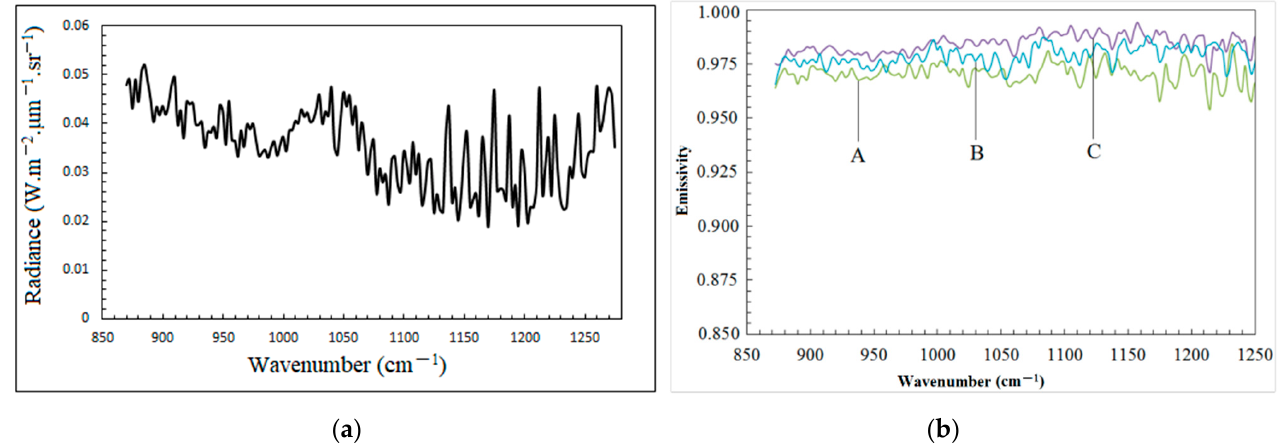
Figure 24. Results of emissivity retrieval and the down-welling radiance. ( a ) is the down-welling radiance retrieved from the gold-plate, and ( b ) the emissivity of Artemisia frigida